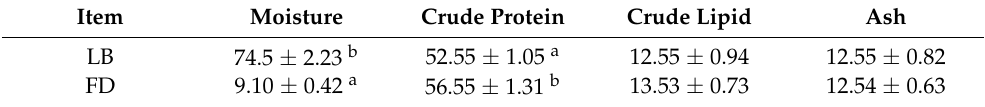
Table 1. Proximate composition of live baits and formulated diet (% dry matter). Item Moisture Crude Protein